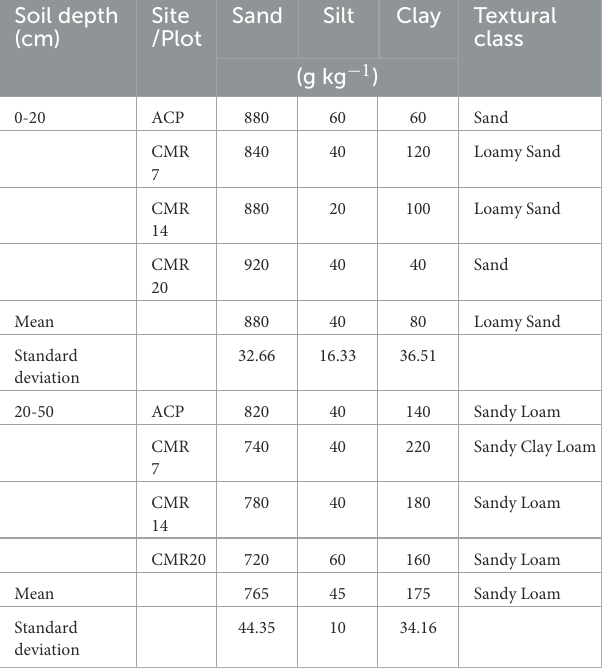
TABLE 2 Particle size distribution of the various cropping systems. Soil depth Site (cm)